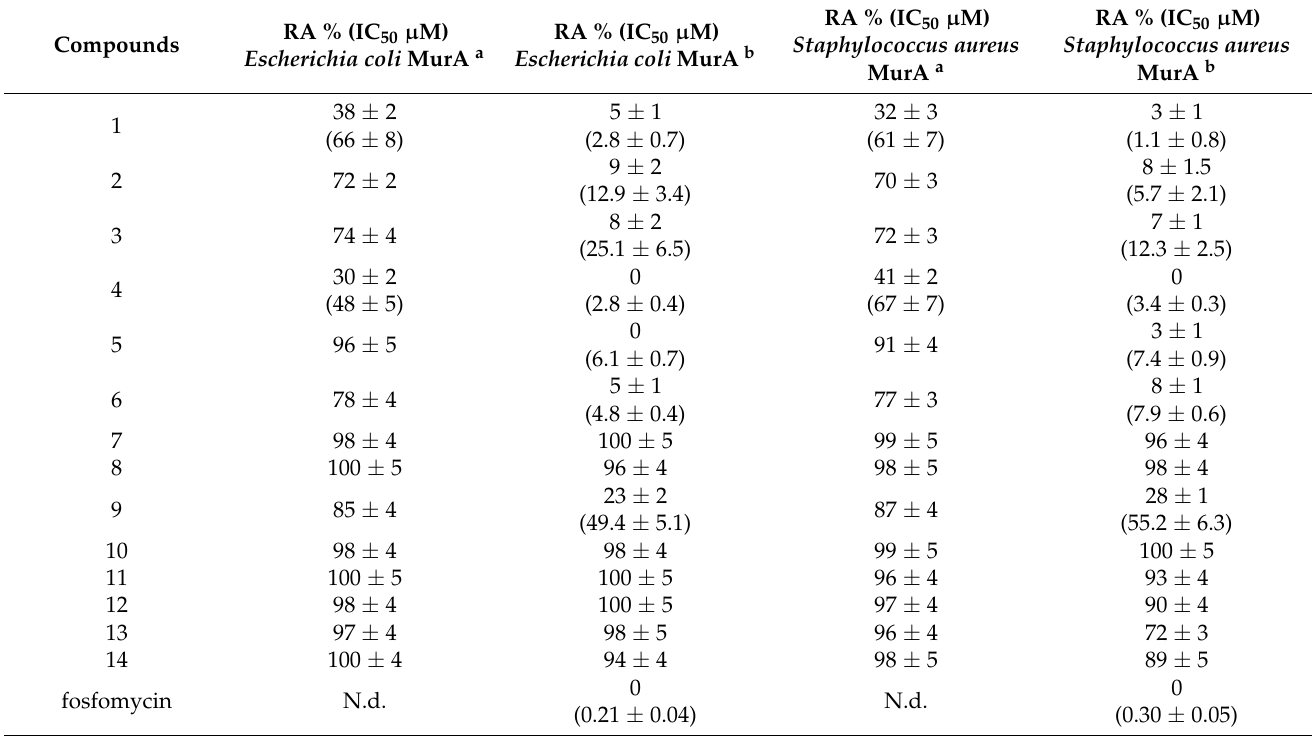
Table 1. Inhibitory effects of compounds 1 – 14 on MurA